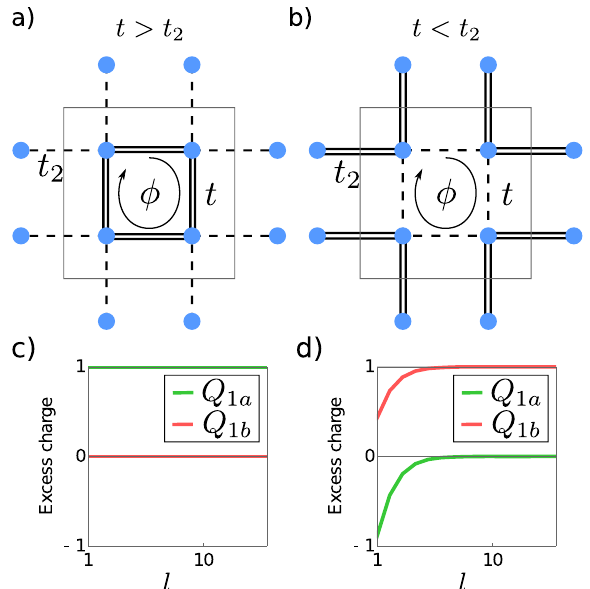
Fig. 3 Quantized corner charges are not uniquely determined by Berry phases and crystalline symmetry eigenvalues. a ) Sketch of the Hamiltonian for one spin sector of the C 4 -symmetric system that realizes an atomic insulating phase at half- fi lling with two electrons at Wyckoff position 1 a or b ) 1 b depending on the parameters. This model is adapted from ref. 58. c ) Behavior of the corner charge density for the phase where two Kramers pairs are localized at 1 a and d ) 1 b as obtained by increasing the l × l corner region size. Note that both phases have the same line invariants and symmetry